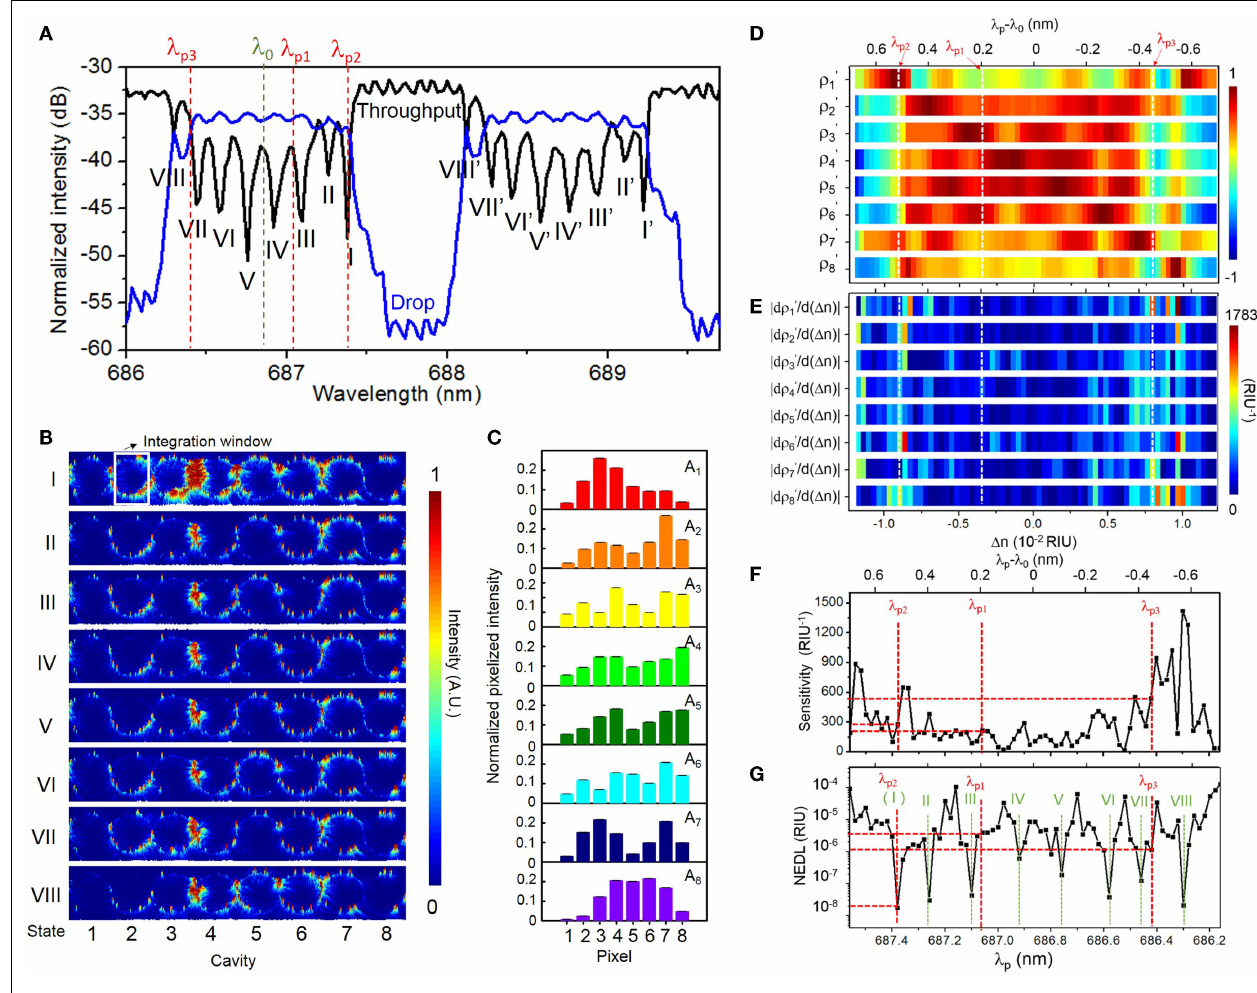
FIGURE 6 | (A) Measured TM-polarized throughput- and drop-port transmission spectra of the eight-microring SiN CROW with DI water upper-cladding. Green and red dashed-lines indicate the reference wavelength λ 0 (686.86nm) and three probe wavelengths, λ p1 (687.06nm), λ λ p2 (687.38nm), and p3 (686.42nm). (B) Measured elastic-light-scattering images with DI water upper-cladding at the eight eigenstates I–VIII. The white-line box indicates the integration window for pixelization. (C) Normalized pixelized mode-field intensity patterns at the eight CROW eigenstates I–VIII. (D) Calculated library of the calibrated correlation